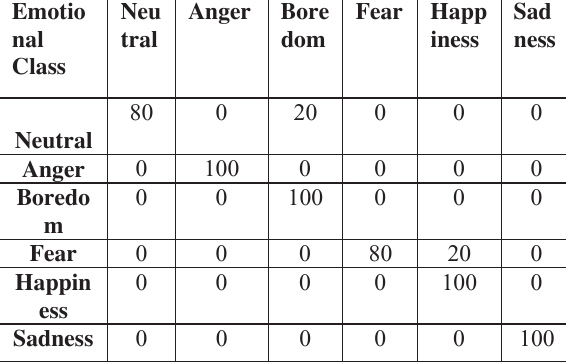
Table 4. Confusion Matrix for recognition using Fusion